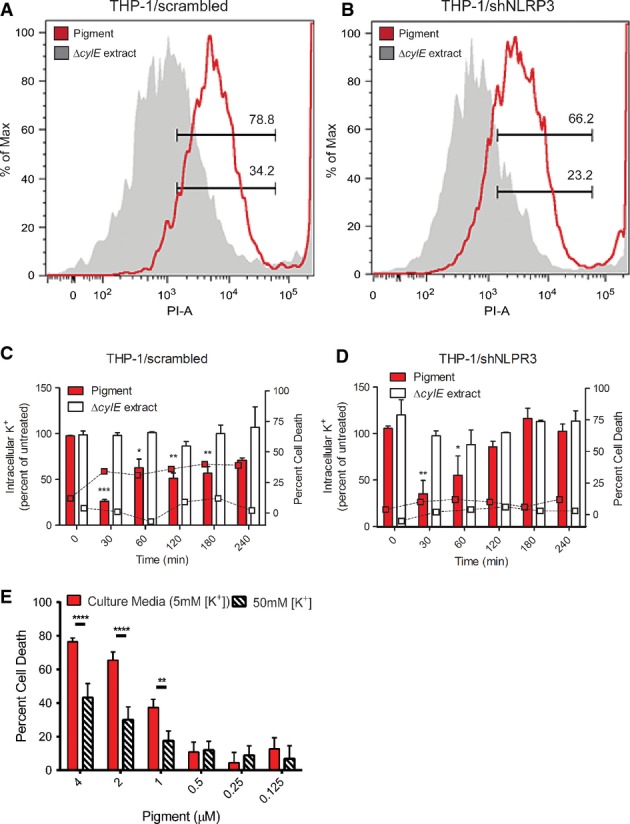
GBS pigment induces membrane permeabilization and K+ efflux independently of the NLRP3 inflammasome
A, B THP-1 macrophages proficient for NLRP3 (transfected with scrambled control, A) or deficient for NLRP3 (shNLRP3, B) were treated with 1 μM pigment or ΔcylE extract for 20 min, and propidium iodide (PI) was added during the final 10 min. PI uptake was measured by flow cytometry, and data shown are representative of two independent experiments.

C, D Intracellular potassium concentration was measured by ICP-AES. THP-1 macrophages transfected with the scrambled control (C) or shNLRP3 (D) were treated with GBS pigment (1 μM) or an equivalent amount of the ΔcylE extract. At various time points, cells were lysed and intracellular [K+] was measured relative to untreated cells (see bars and left y-axis), and percent cell death was quantified by alamar blue (see squares, dotted connecting lines and right y-axis). Both NLRP3-proficient and NLRP3-deficient macrophages initially lose intracellular K+ due to GBS pigment (compare t = 0 min to t = 30 min), but the NLRP3-deficient cells (shNLRP3) are able to recover, while the scrambled control do not, demonstrating that initial K+ loss occurs independently of NLRP3. Data are average of three independent experiments performed with independent pigment preparations in triplicate and were analyzed using Dunnett's multiple comparison test following ANOVA; all data were compared to control at t = 0, error bars ± SEM. (C) n = 3, ***P = 0.0002, *P = 0.019, **P = 0.0032 for 120 min, **P = 0.0072 for 180 min. (D) n = 3, **P = 0.0043, *P = 0.031. (E) WT THP-1 macrophages were incubated with pigment in media containing either 5 mM or 50 mM potassium chloride, and cytotoxicity was measured by alamar blue assay. The addition of potassium chloride is able to protect the macrophages from cytolysis, demonstrating that K+ efflux is essential for this process. Data shown are three independent experiments performed in triplicate and were analyzed using Bonferroni's multiple comparison test following ANOVA, error bars ± SEM (n = 3, ****P < 0.0001, **P = 0.0036).